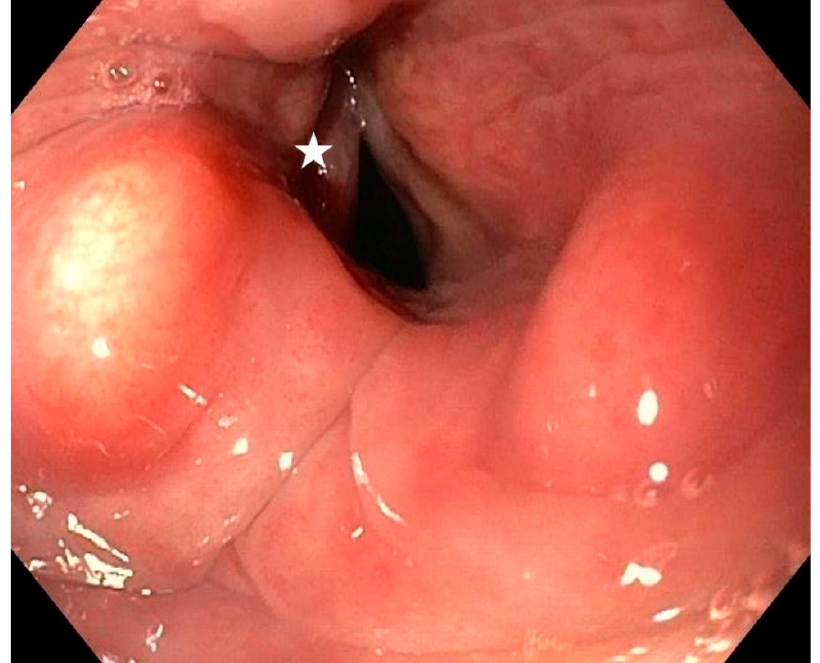
Figure 1. Asymmetry of the glottis during breathing on laryngoscopy. Left vocal fold paralysis (as- terisk).